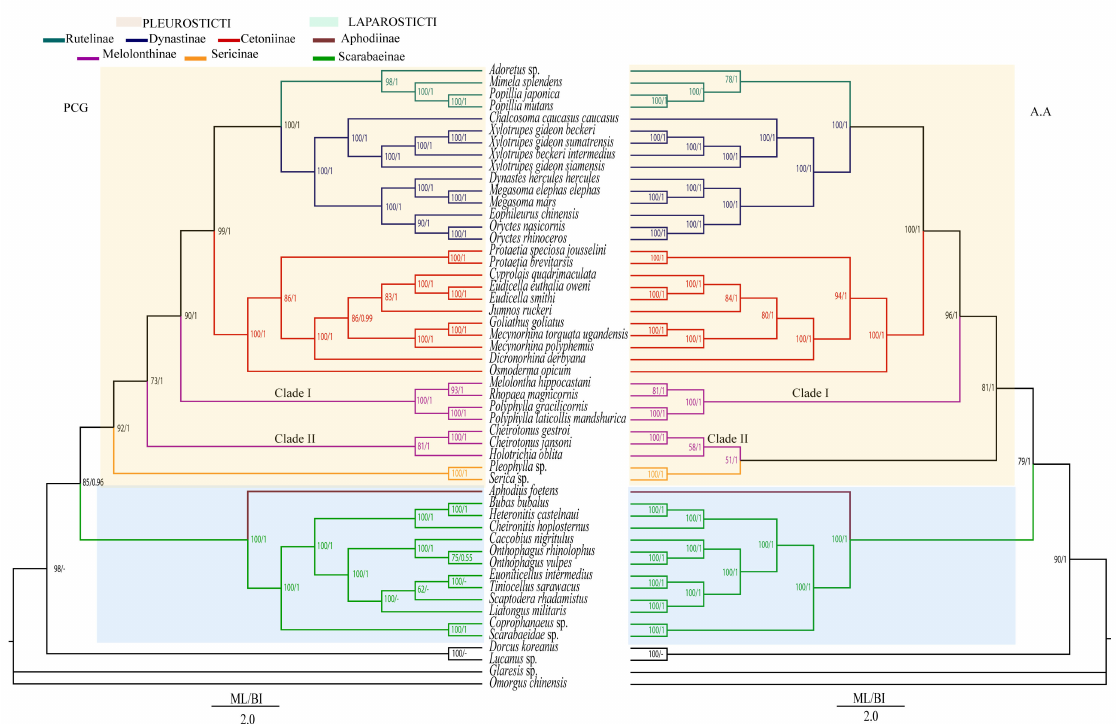
Figure 3. Phylogenetic relationships inferred by the ML and BI methods based on nucleotide (PCG, Left ) and amino acids (AA, Right ) datasets. Numbers on nodes are the posterior probabilities of BI ( Right ) and Bootstrap values of ML ( Left ). Different branch colors correspond to subfamily